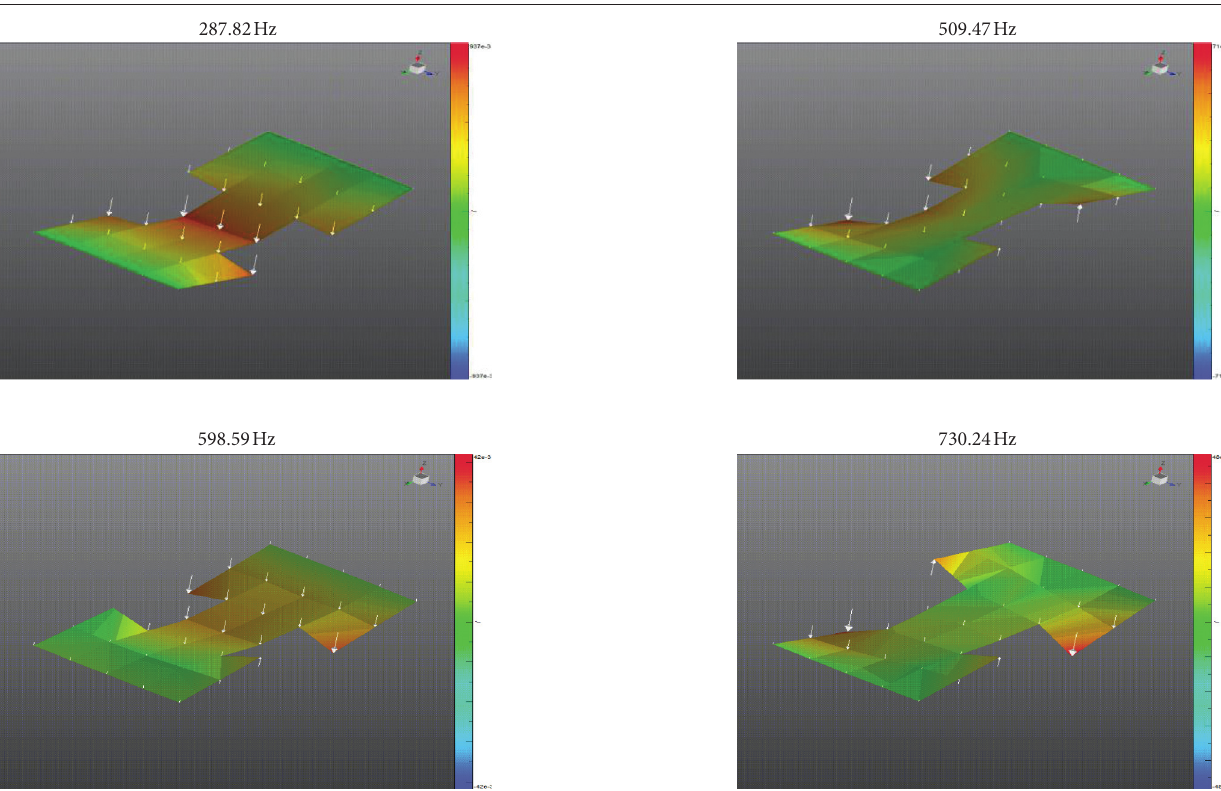
Table 17: Experimental modal analysis: mode shapes and natural frequencies (Case